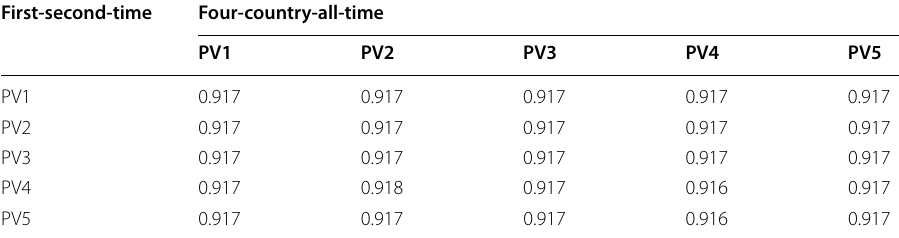
All correlations are significant, df